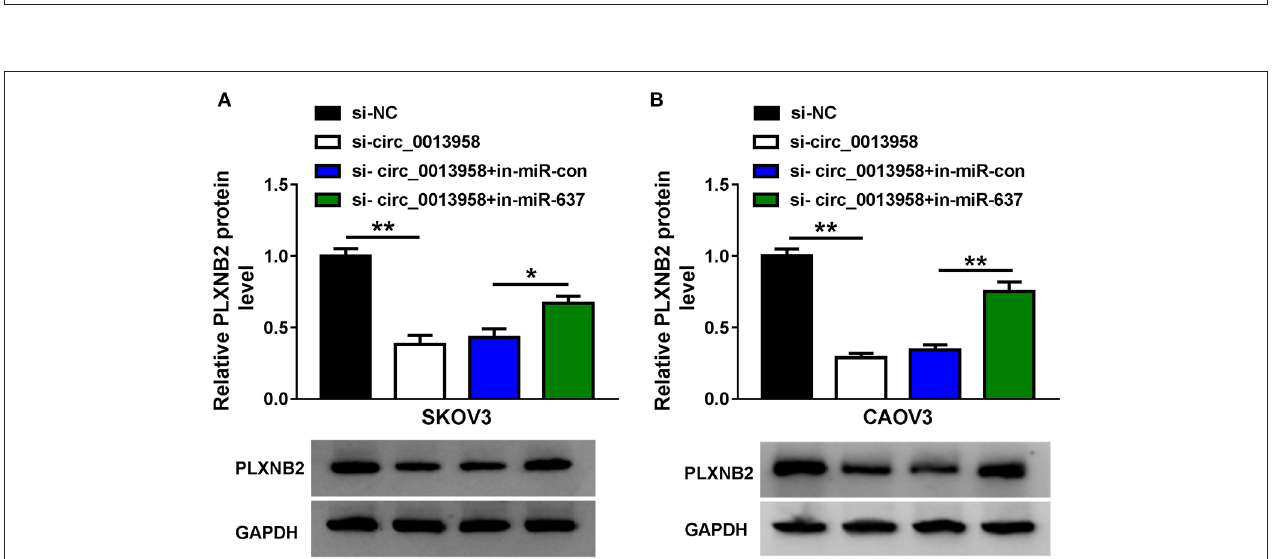
FIGURE 6 | Circ_0013958 positively regulated PLXNB2 expression by absorbing miR-637. (A,B) Western blot assay for the protein level of PLXNB2 in SKOV3 and CAOV3 cells transfected with si-NC, si-circ_0013958, si-circ_0013958 + in-miR-con, or si-circ_0013958 + in-miR-637. * P < 0.05; ** P < 0.01.